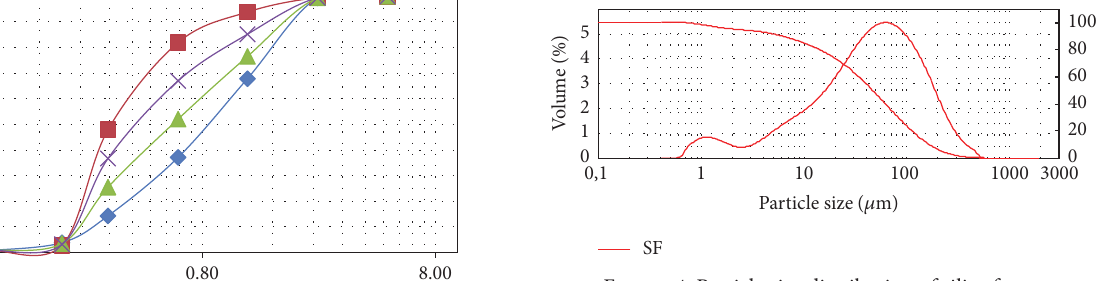
Figure 4: Particle size distribution of silica